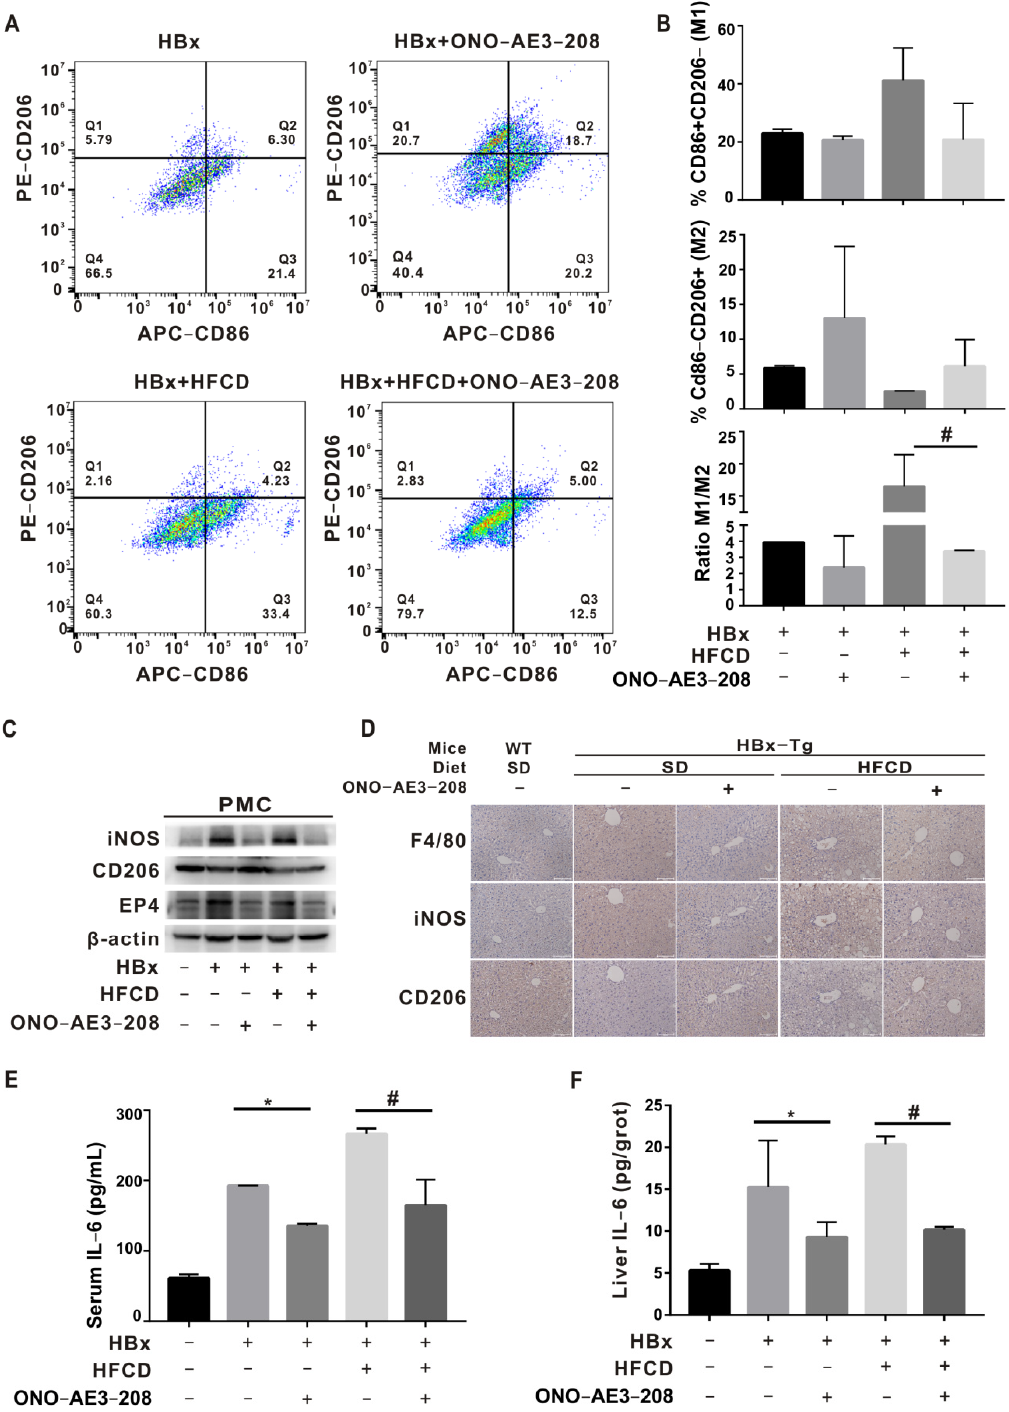
Figure 5. EP4 intervention rescued hepatic macrophage polarization imbalance in vivo. ( A – C ) PMCs were isolated by liver perfusion from different HBx-Tg mouse models. ( A ) Flow cytometry of the M1/M2 polarization phenotype in mononuclear-derived Kupffer cells. ( B ) Quantitative analysis of M1(CD86)/M2(CD206) polarization. ( C ) WB detection of EP4, iNOS, and CD206 in PMCs. ( D ) Representative images of the IHC staining of F4/80, iNOS, and CD206 in liver tissue sections are shown. Scale bar 100 μ m. ( E , F ) ELISA detection of IL-6 levels in serum ( E ) and livers ( F ). The data are presented as the mean ± SD. * p < 0.05, compared with the HBx group. # p < 0.05, compared with the HBx + HFCD group.